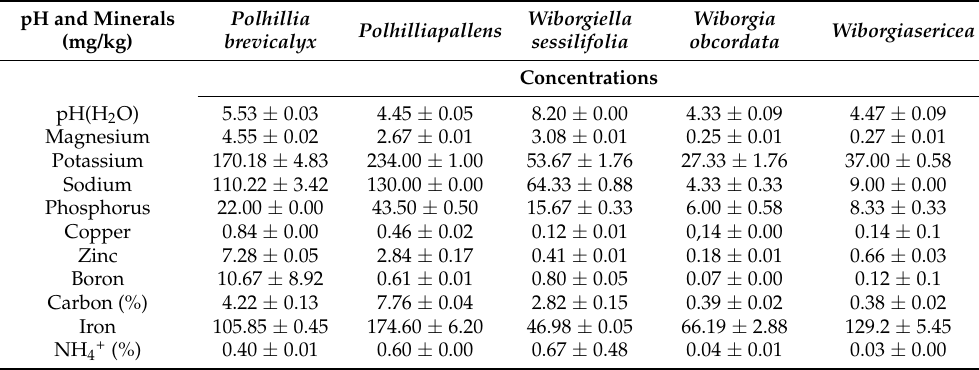
Table 3. Wet season rhizosphere soil chemical properties of Polhillia, Wiborgia and Wiborgiella species sampled from five different locations of the South African Cape fynbos in